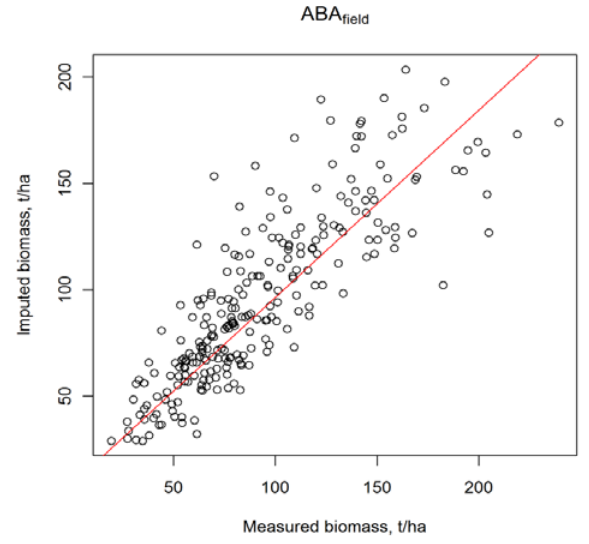
-imputed biomass, field